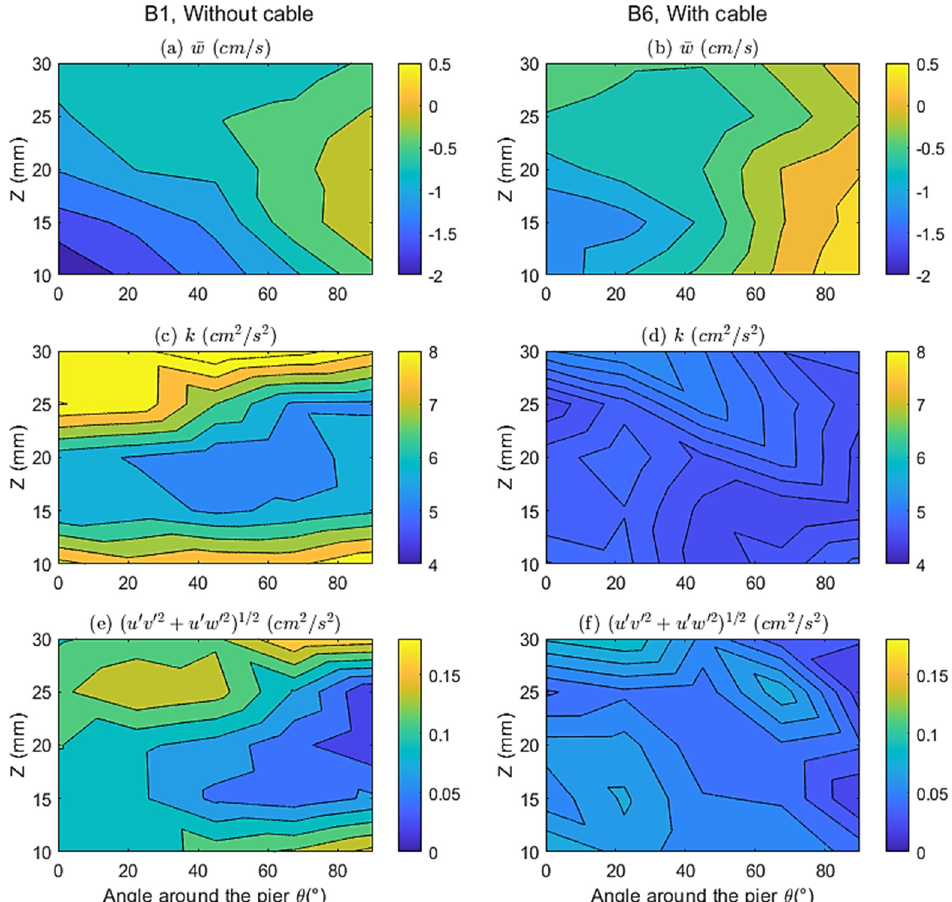
Figure 8. Time-averaged ( a , b ) vertical velocity, ( c , d ) turbulent kinetic energy, and ( e , f ) modulus of vertical and horizontal Reynolds stress components at points 1 (0°), 2 (22.5°), 3 (45°), 4 (67.5°) and 5 (90°) around the pier (see Figure 1b) and through the water column (z is measured from the bed) for the fine sediment ( d 50 = 0.86 mm) for the unprotected pier (B1) ( left ) and the protected pier with a 10 mm diameter wrapped cable (B6) ( right